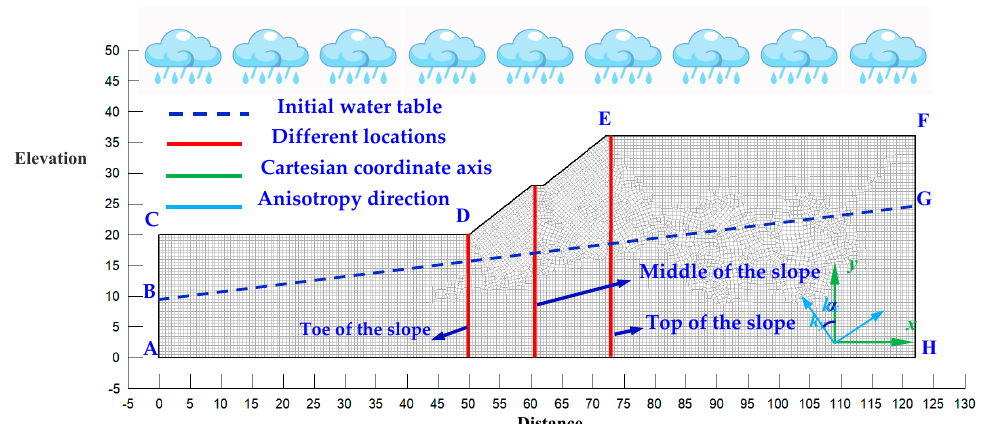
Figure 1. Illustration of slope model.